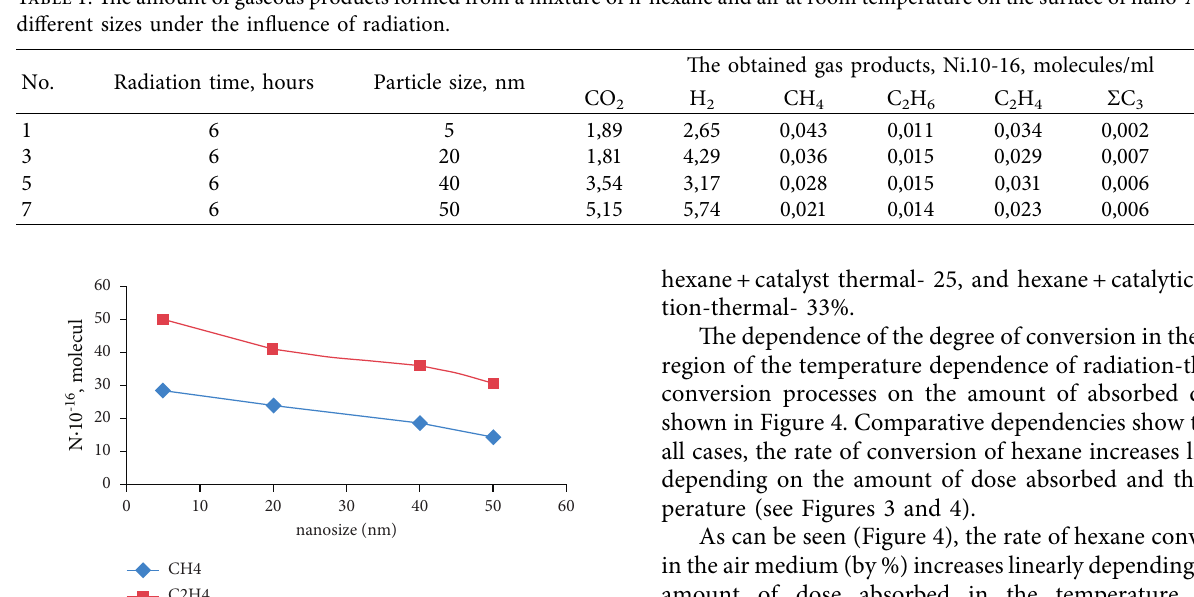
Figure 1: Dependence of gases from radiation catalytic decom- position of hexane on the size of the nanocatalyst.